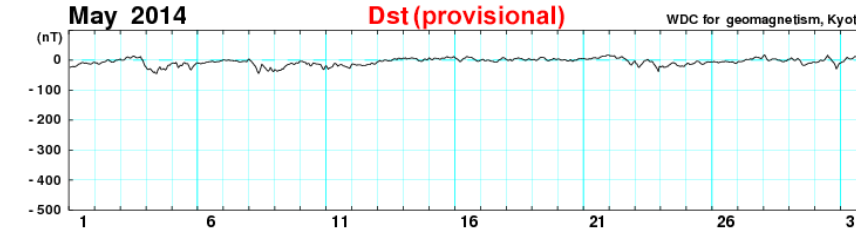
Figure 8. D st index value for analysed days.